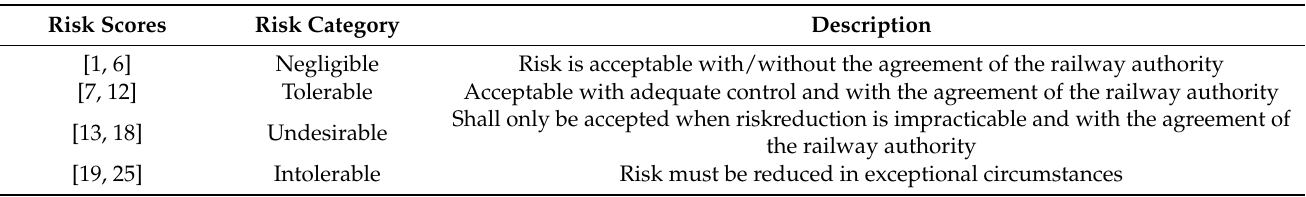
Table 13. Two-dimensional risk matrix acceptance criteria.